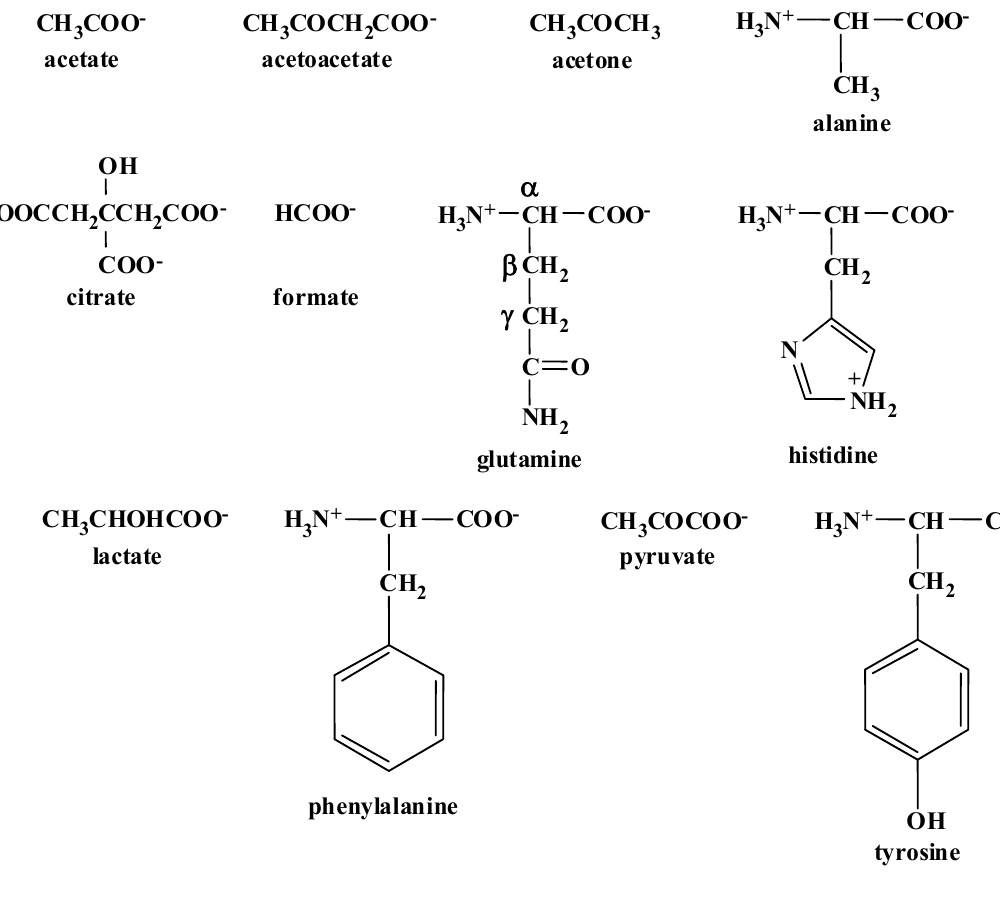
Figure 2. Chemical structures of the CSF metabolites discussed in this